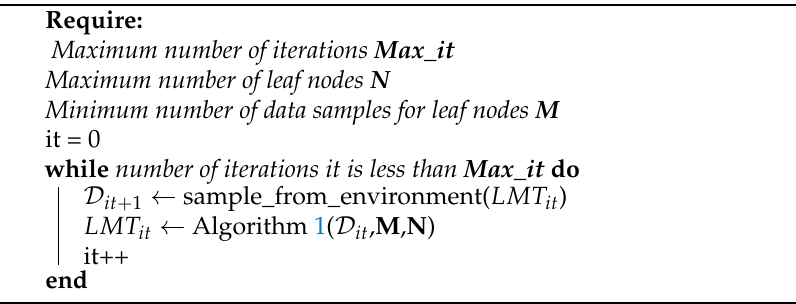
Algorithm 2: The data sampling process from